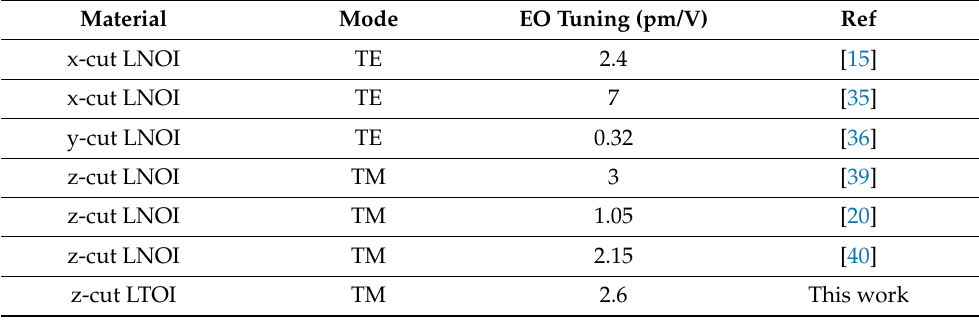
Figure 9. Diagram showing the electrostatic field strength when a voltage is applied to the electrodes. Table 2. Comparison between the different types of LiNbO 3 and LiTaO 3 tunable microrings.